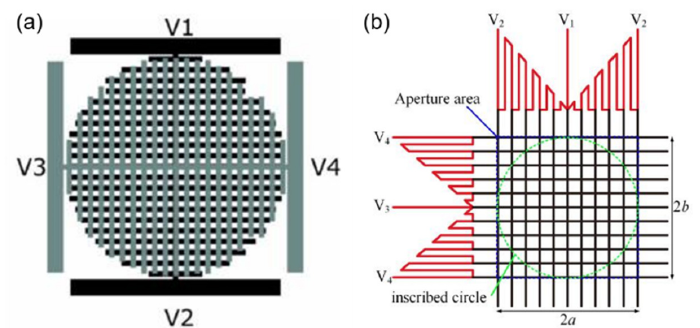
Figure 9. Pattern electrodes with parallel sub-electrodes. ( a ) Two electrode structures perpendicularly arranged, corresponding to the top and bottom substrates of a LC-cell [57]. ( b ) Resistance line distribution with a linear function of the coefficient k [63]. Reprinted with permission from Refs. [57,63]. 2020 Springer Nature and 2022 IEEE.